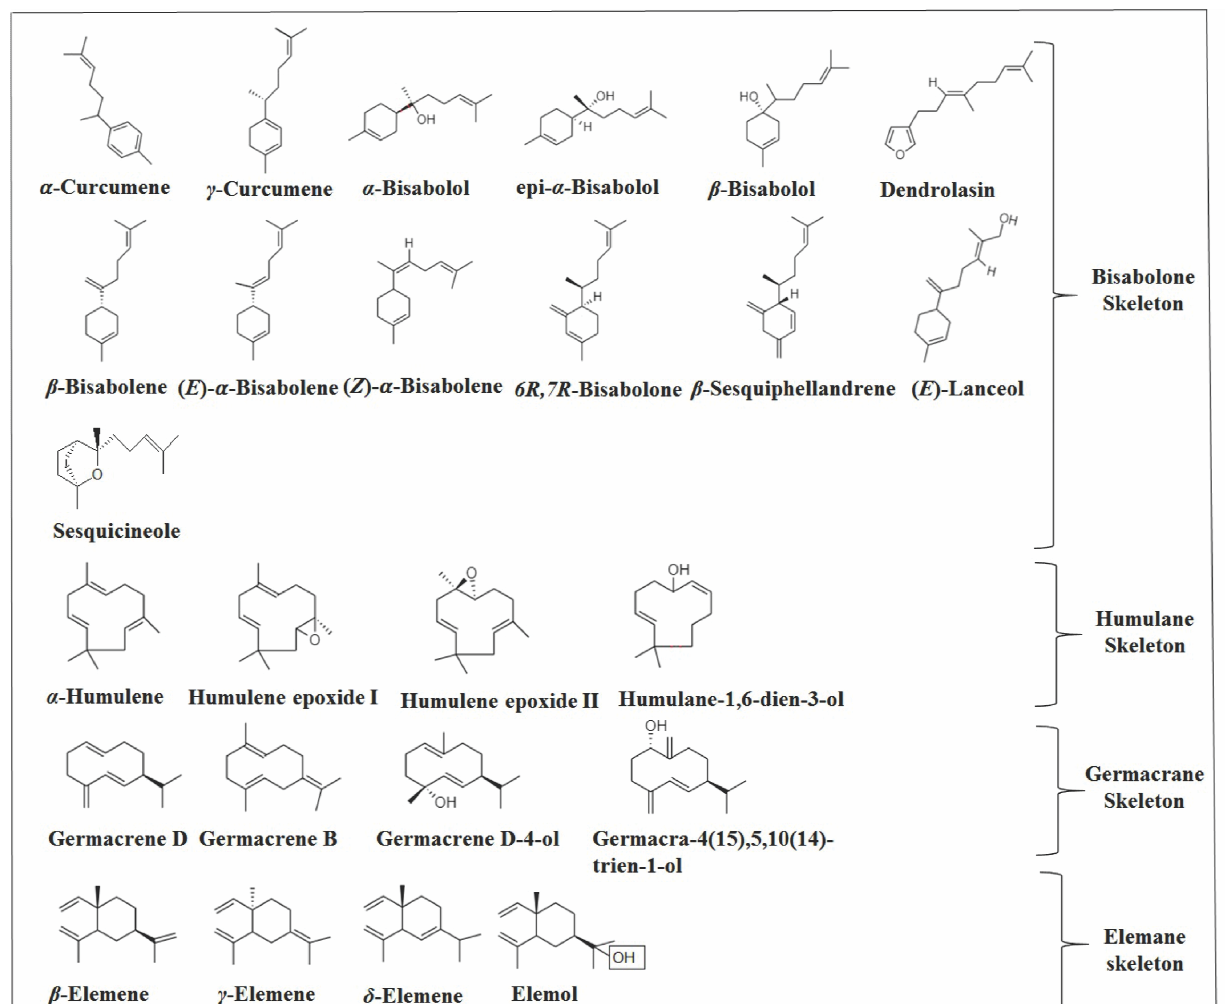
Figure 4. Structures of monocyclic sesquiterpenes in Vitex species.